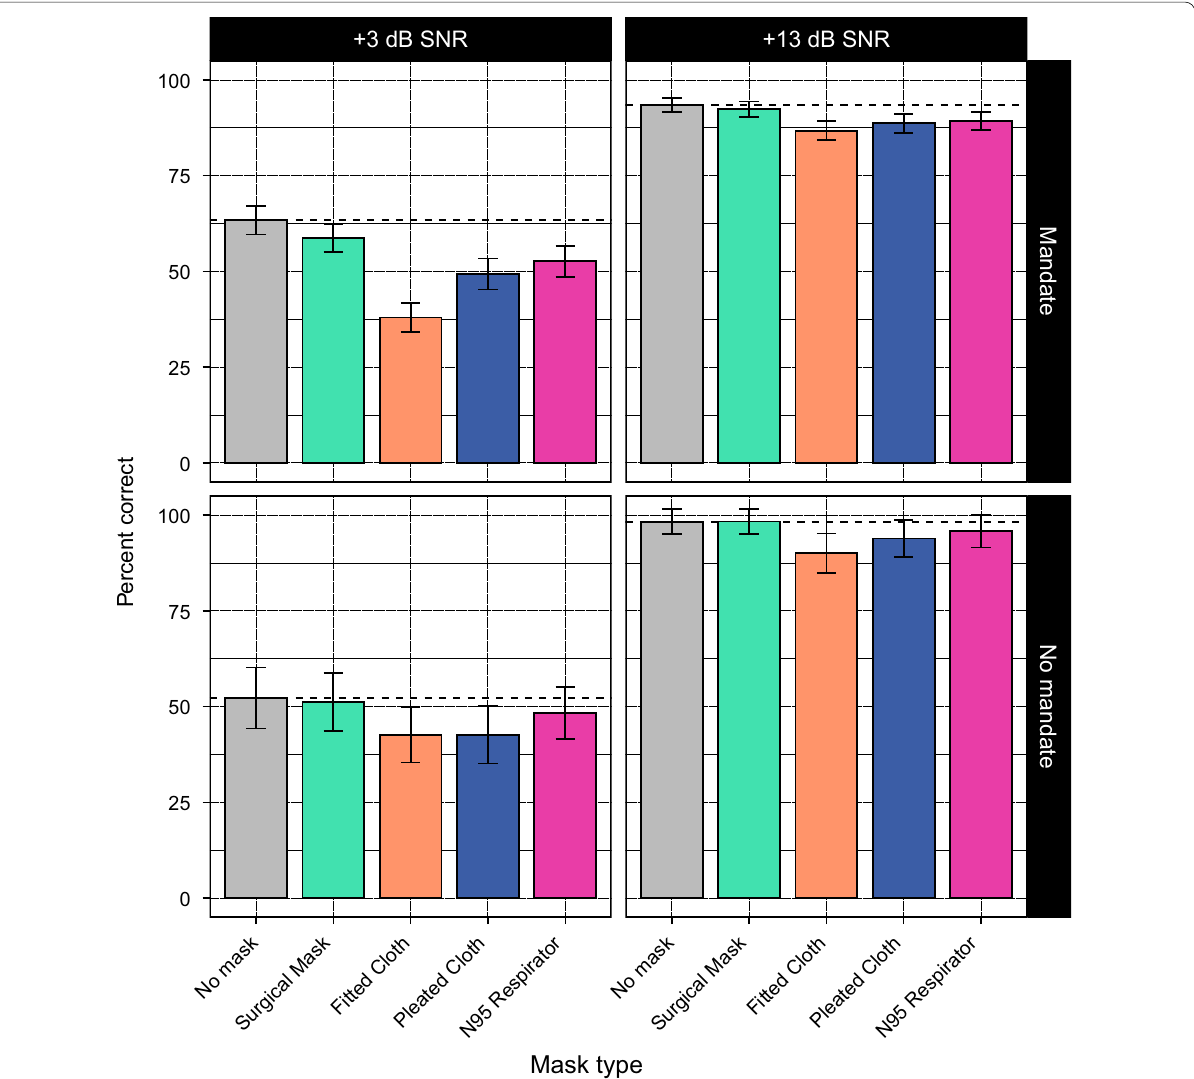
Fig. 5 Average performance by mask and SNR, grouped by whether participants’ state of residence implemented a public mask mandate during the pandemic ( no mandate = 41 participants; mandate = 138 participants). There were no differences as a function of mask mandates. Dashed lines indicate the average performance for the no-mask condition in each panel. Error bars indicate 95% confidence